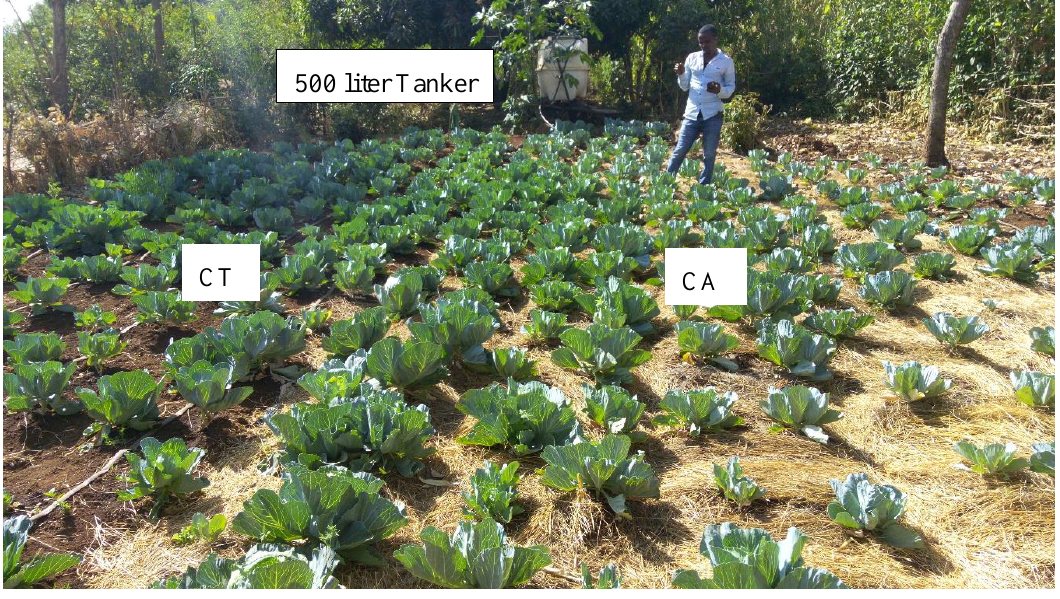
Figure 2. Gravity based drip irrigation system on a paired ‘t’ experimental design; half of the plot was used for conservation practice and the other half is the conventional tillage practice.